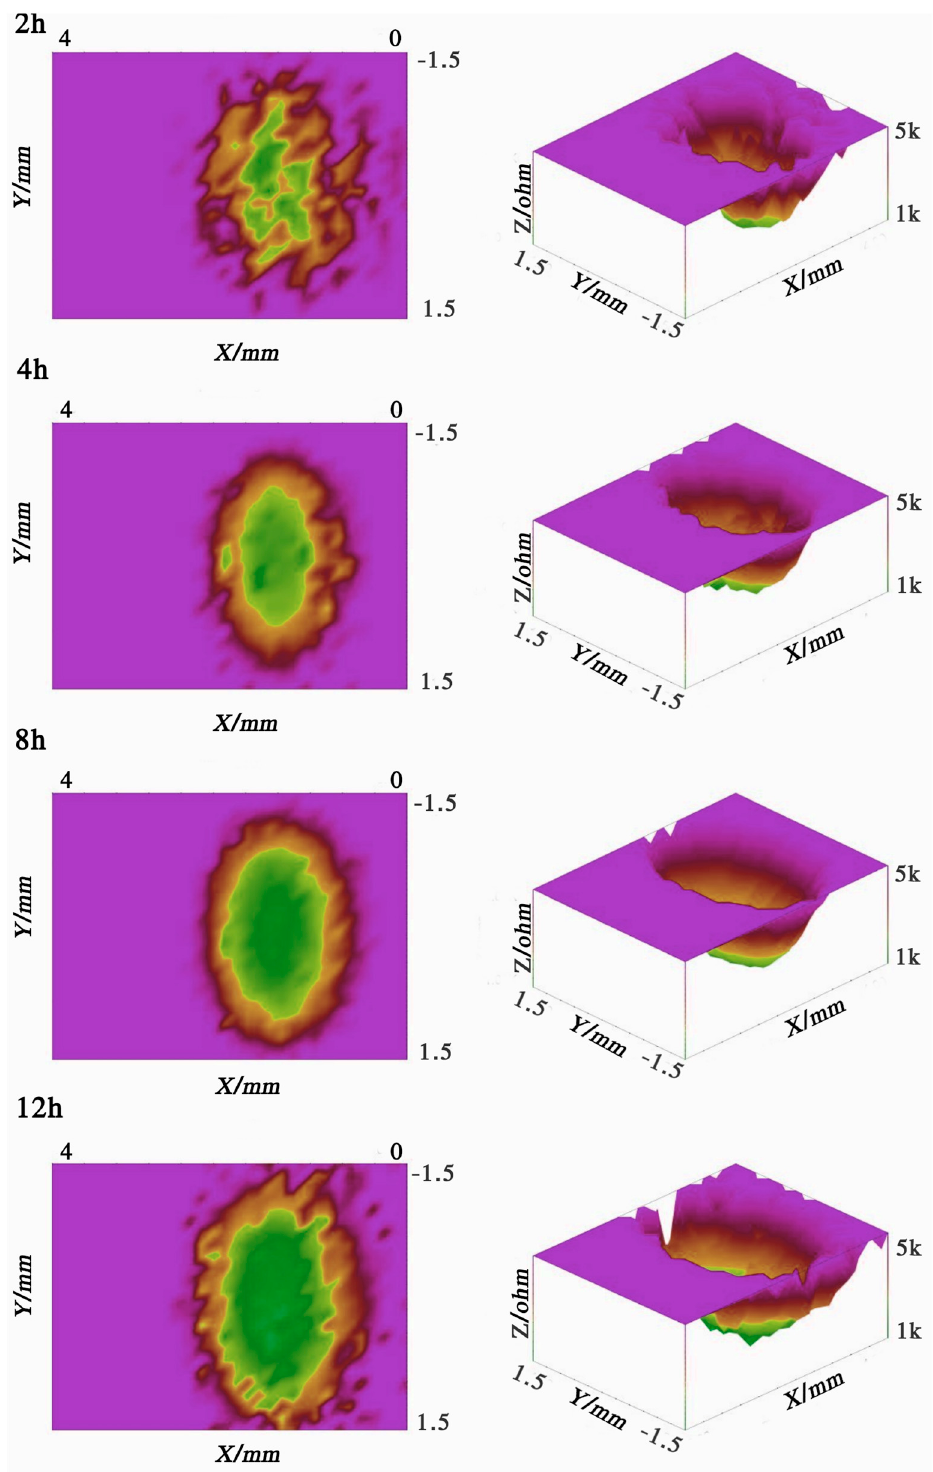
Figure 17. Local electrochemical impedance maps (LEIM) obtained for the 212 sample. Frequency: 10 Hz. Immersion time: 2, 4, 8 and 12 h. Electrolyte: 0.001 M NaCl aqueous solution.